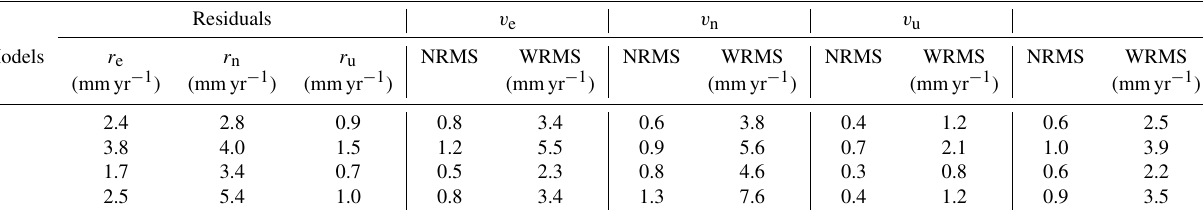
Table 1. Inversion results for the four models described in Sect. 5.1. Residual values (columns 2–4), NRMS (columns 5, 7, 9), and WRMS (columns 6, 8, 10) are indicated for each component of the velocity field and for the whole dataset (columns 11–12). Residuals v e v n v u Models